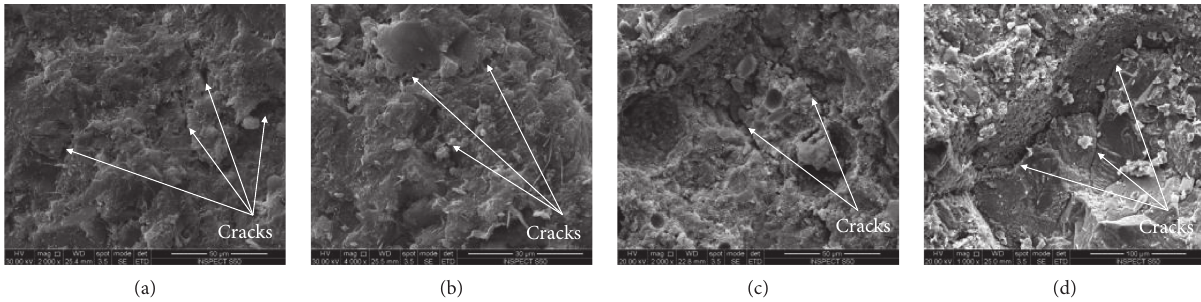
Figure 6: SEM maps of C3-7 after (a) 30, (b) 110, (c) 190, and (d) 270 days of